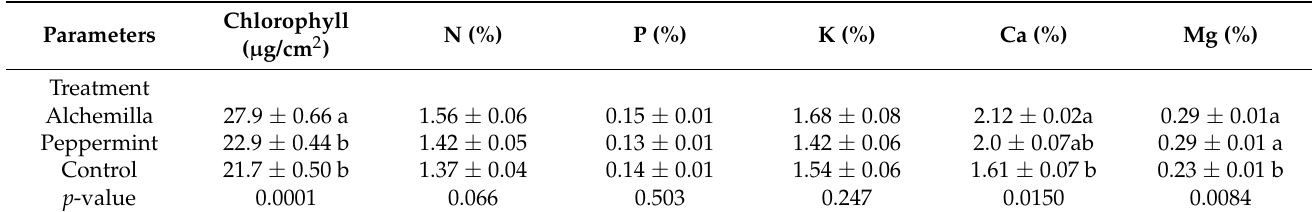
Table 2. Effect of different row living mulches on chlorophyll and leaf macro-nutrients content in apple leaves. Parameters Treatment